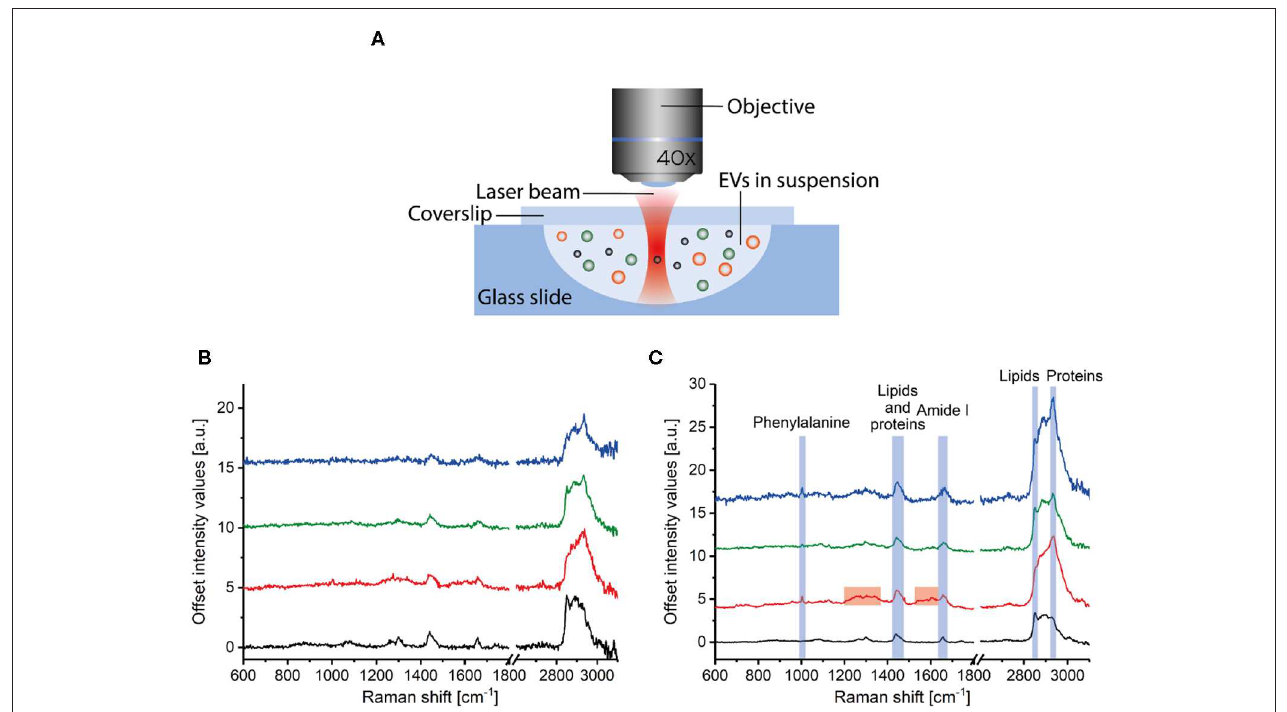
FIGURE 6 | Raman spectroscopy of extracellular vesicle (EV) samples. (A) Particles in suspension are loaded in a well glass slide that is mounted under a microscope objective. Incident light illuminates the sample, and both Raman and Rayleigh light are backscattered, collected by the lens, and detected by a spectrograph. Raman spectra corresponding to (B) single and (C) multiple PC3 EVs (blue), LNCaP EVs (green), red blood cell EVs (red), and lipoproteins in plasma (black). (A) is adapted from Enciso-Martinez et al. ( 18).